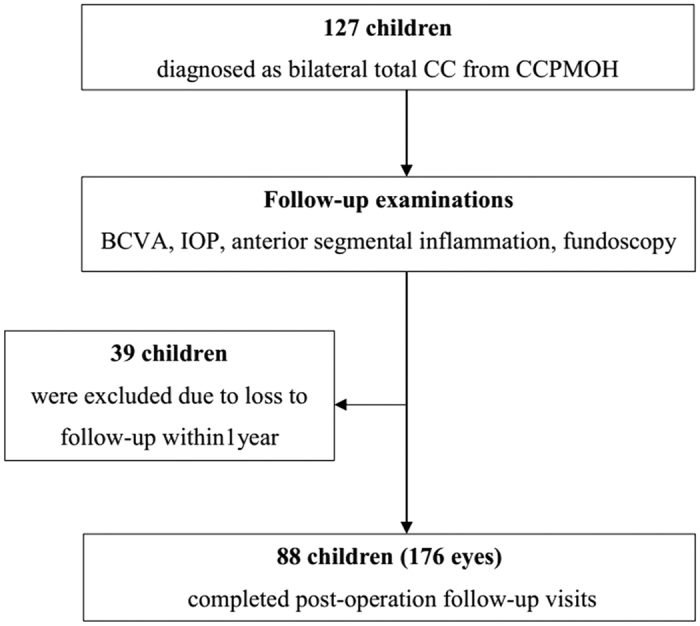
Flowchart of patient selection.CC = Congenital cataract; CCPMOH = Childhood Cataract Program of the Chinese Ministry of Health; BCVA = Best-corrected visual acuity.